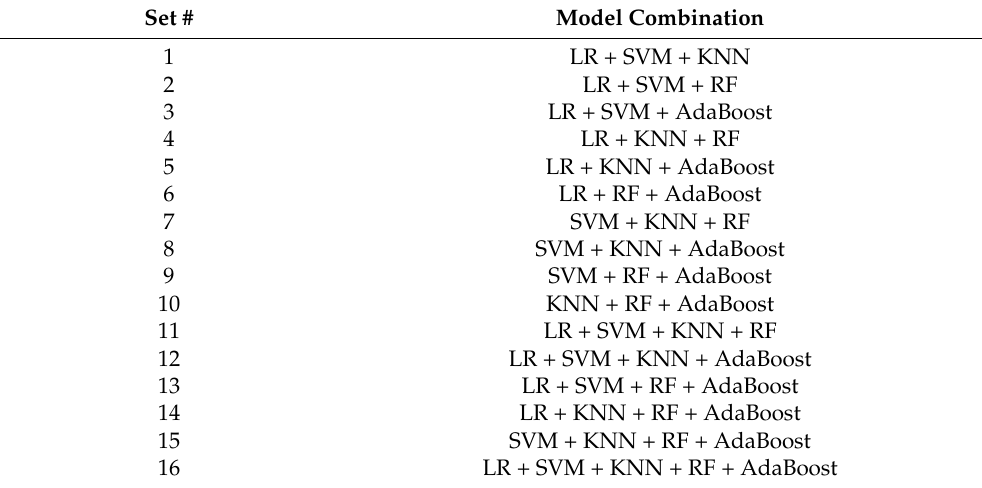
Table 1. The set numbers and the related learning model combinations for the voting